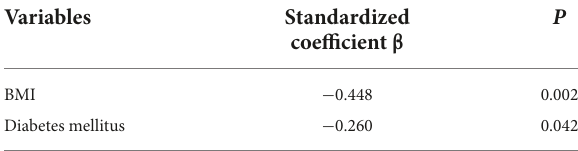
TABLE 3 The association of sLAG3 with BMI and diabetes mellitus.